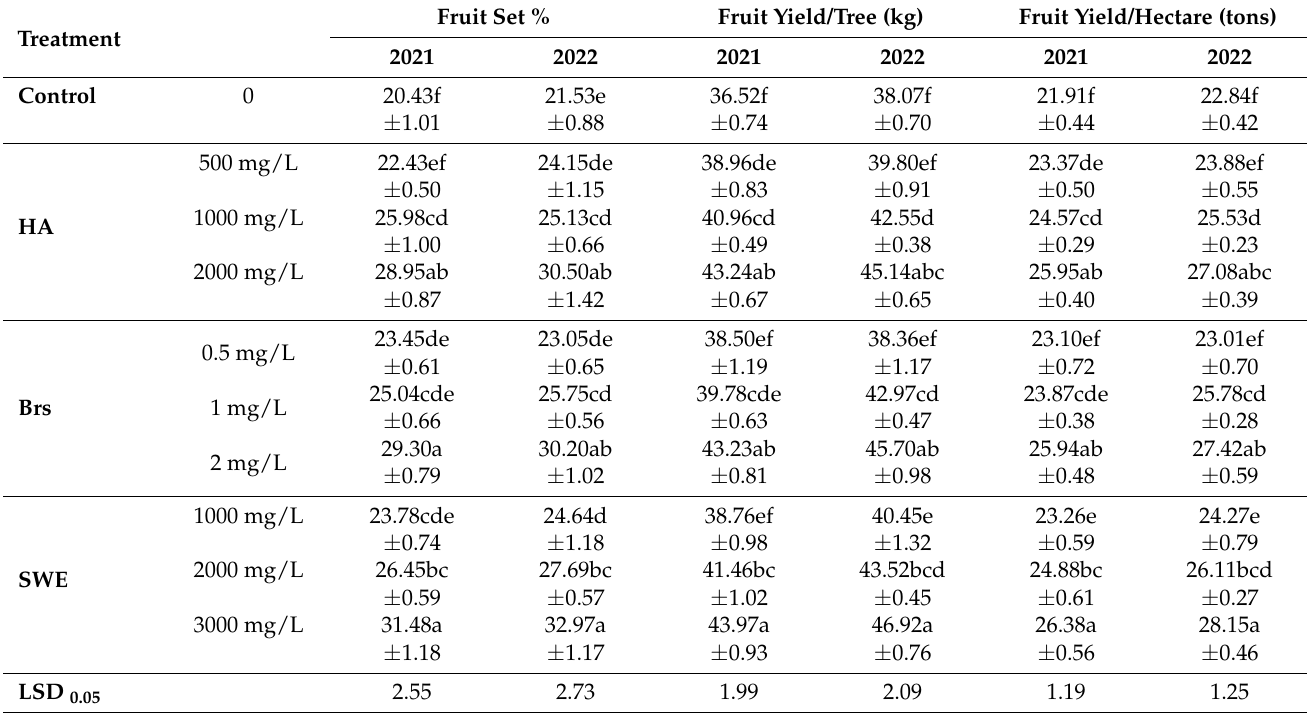
Table 5. Effect of foliar spraying of HA, Brs, and SWE on the fruit set percent, fruit yields in kilograms, or tons of apricot cv. Canino during